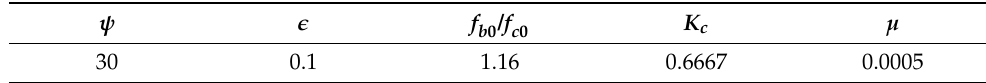
Table 2. Parameters of ABAQUS concrete plastic